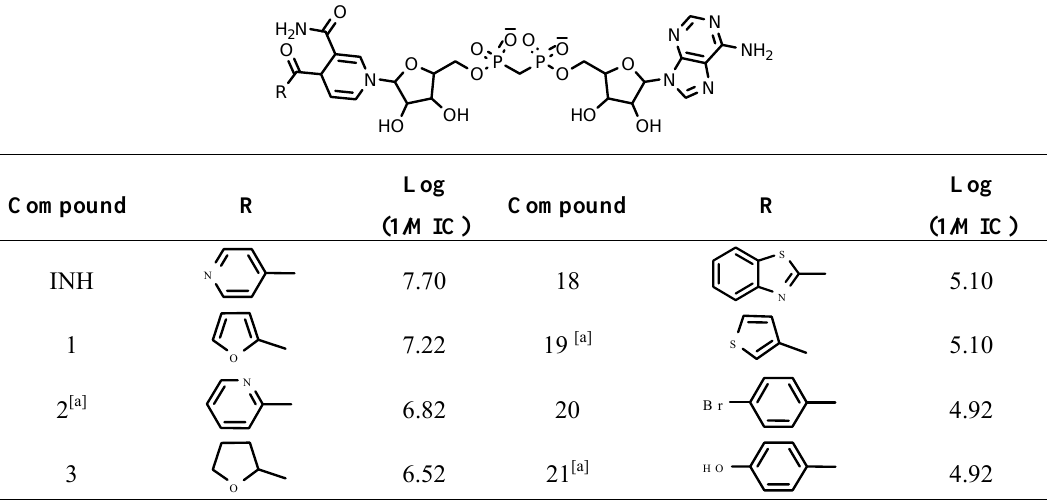
Table 1. The chemical structures and experimental biological activities against the BCG strain of M. tuberculosis of INH derivatives taken from literature